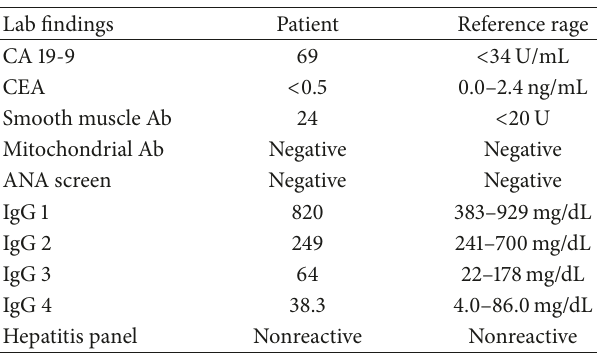
Table 2: Immunological